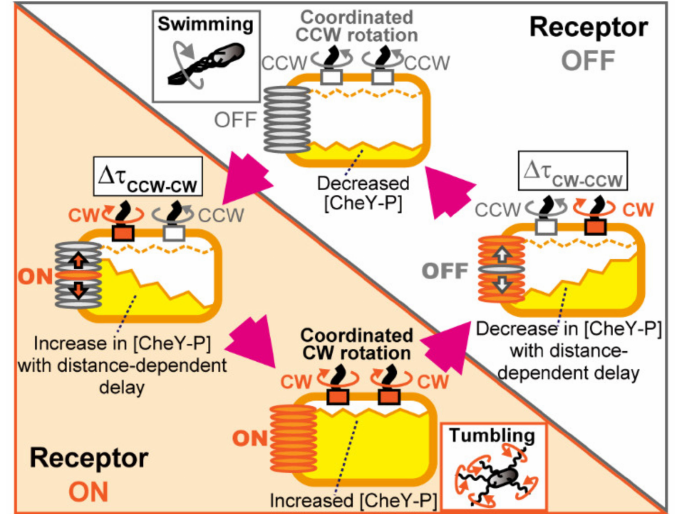
Figure 6. A model for intracellular signaling in an E. coli cell under steady-state conditions with no external stimuli. The orange-hatched and white-hatched triangles indicate times when the receptor array is active or inactive, respectively. When the receptor units (the receptor / CheW / CheA complexes) are in an inactive state (depicted as gray ellipses located at cell pole), flagellar motors on the same cell rotate CCW. When one or small numbers of the receptor units are activated (orange ellipse depicted in left cell), its activation is propagated through the receptor array and / or sub-arrays (multiple interconnected segments in the array) because of the cooperativity among the receptor units. The CheY-P concentration increases at the cell pole through the activity of CheA, and the increase propagates through the cytoplasm by di ff usion with a delay dependent on the distance from the receptor array (yellow area within a cell). Therefore, two flagellar motors coordinately switch rotational direction from CCW to CW with a delay (left and bottom cells). On the other hand, when one or several of the receptor units is inactivated (gray ellipse depicted in right cell), its inactivation is propagated through the receptor array and / or sub-arrays because of the cooperativity among the receptor units. The CheY-P concentration is decreased at the cell pole through the activity of CheZ with a delay dependent on the distance from receptor array due to the di ff usion of CheY-P molecules. Therefore, two flagellar motors coordinately reverse their rotational direction from CW to CCW with a delay (right and top cell). In the steady-state, the spontaneous blinking in activity of receptor array causes the fluctuation in CheY-P concentration that coordinates the switching of rotational direction among the flagellar